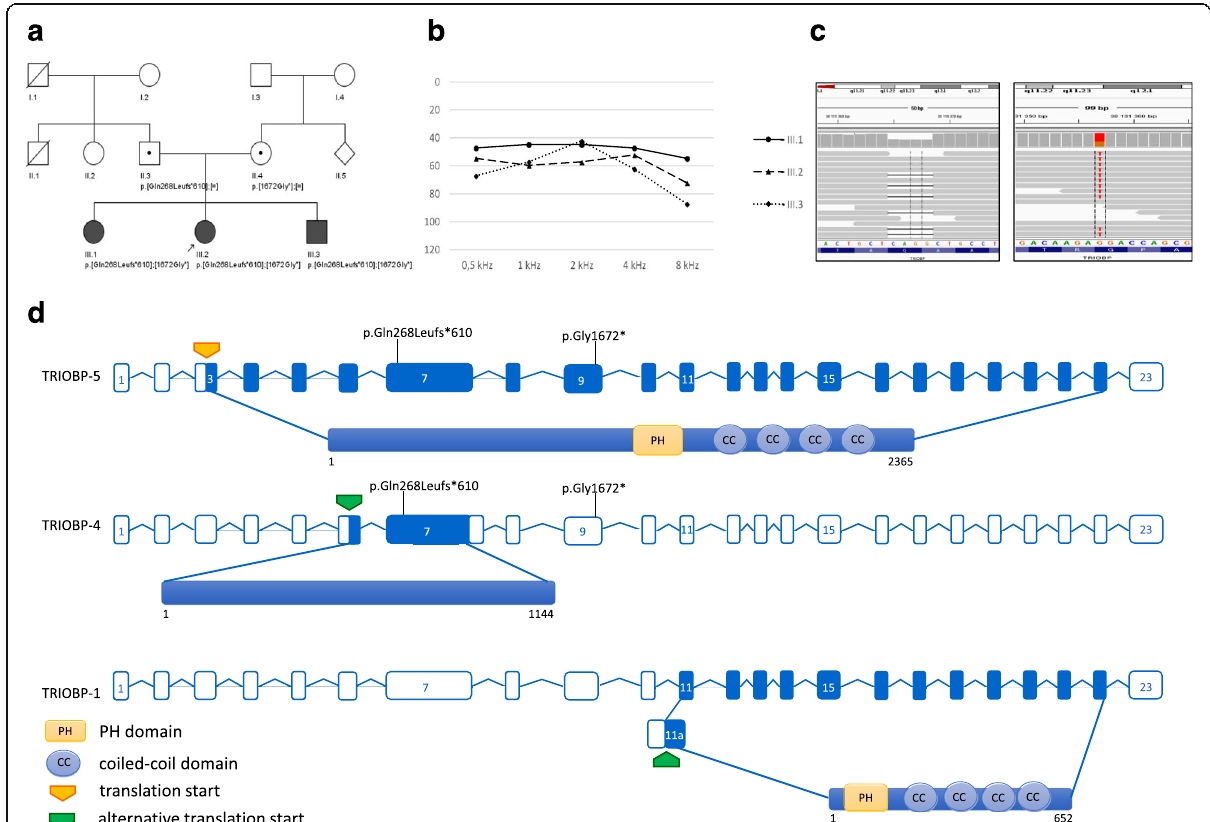
Fig. 1 Structure and variants of TRIOBP in the studied family with HI. a . Pedigree of the analyzed family. Circles and squares represent females and males, respectively. Black arrow denotes the proband, genotypes of the TRIOBP gene are given below the respective symbols. b . Mean audiograms for both ears in all affected siblings (III.1, III.2, III.3) (Y axis presents HI level in dB, X axis presents the tested frequency in kilohertz). c . TRIOBP pathogenic variants identified in this study - Integrative Genomics Viewer (IGV) views for c.802_805delCAGG, p.Gln268Leufs*610 (left panel) and c.5014G>T, p.Gly1672* (right panel). d . Schematic localization of the c.802_805delCAGG, p.Gln268Leufs*610 and c.5014G>T, p.Gly1672* variants within the TRIOBP gene. Upper panels show the TRIOBP gene structure, whereas the lower panels present three isoforms, TRIOBP-5, TRIOBP-4 and TRIOBP-1, respectively. All of them are in the same reading frame. TRIOBP-4 translation starts from an alternative start site in exon 6, whereas TRIOBP-1 translation start is localized within an alternative exon 11a. Numbers given below the particular isoforms denote first and last amino